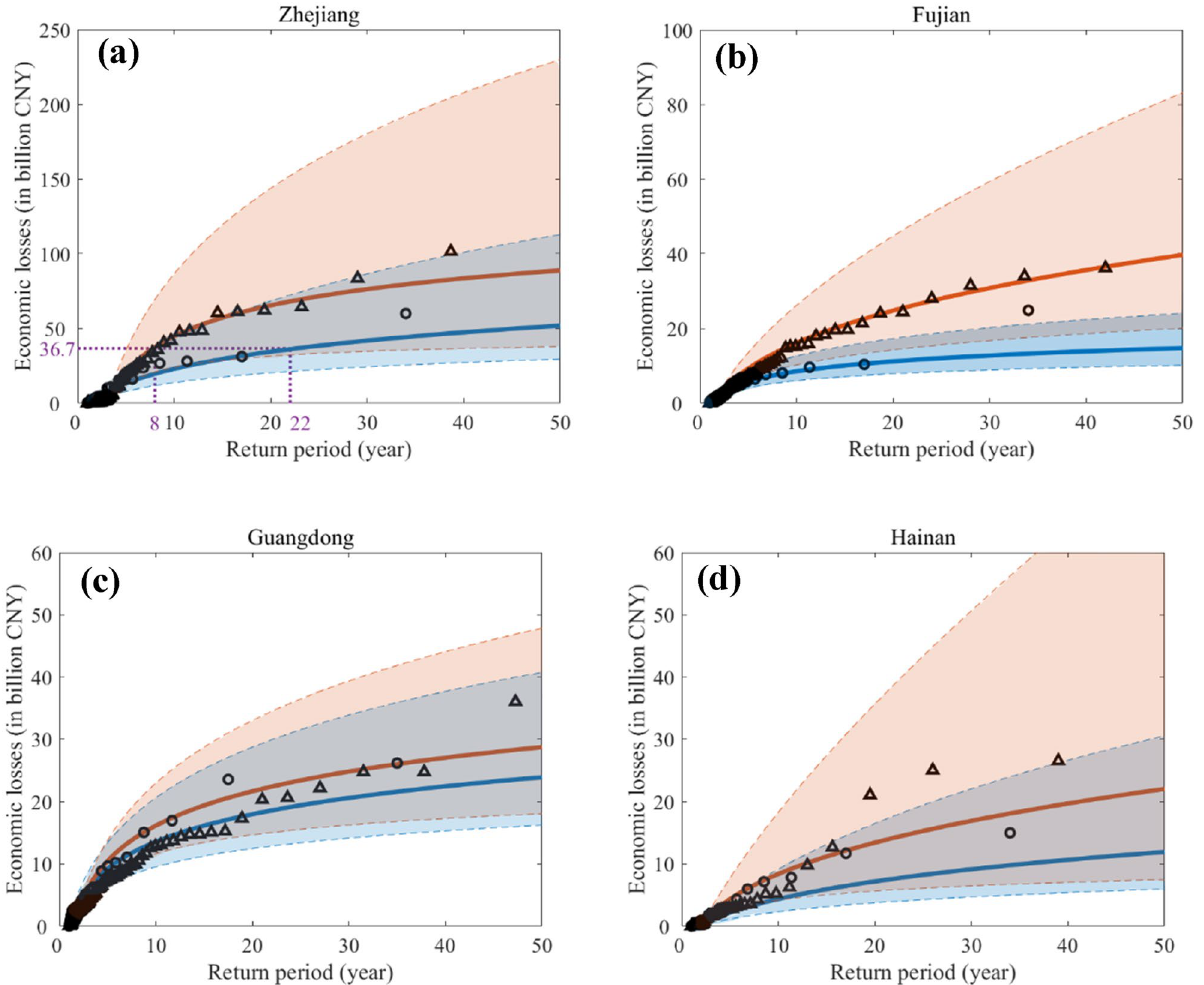
Figure 4. Return period curves of typhoon economic losses for four coastal provinces of China: Zhejiang ( a ), Fujian ( b ), Guangdong ( c ) and Hainan ( d ). Red lines correspond to the future climate during 2080 to 2100. Blue lines correspond to the historical period of 1980 to 2018. Solid lines represent the best estimates of economic loss return periods. Shaded areas cover the very likely range estimates (i.e., 95% statistical confidence interval). Black triangles represent predicted future typhoon-induced losses; black hollow circles represent historical observed typhoon losses. Maps were generated by MATLAB R2021a (http:// www. mathw orks.